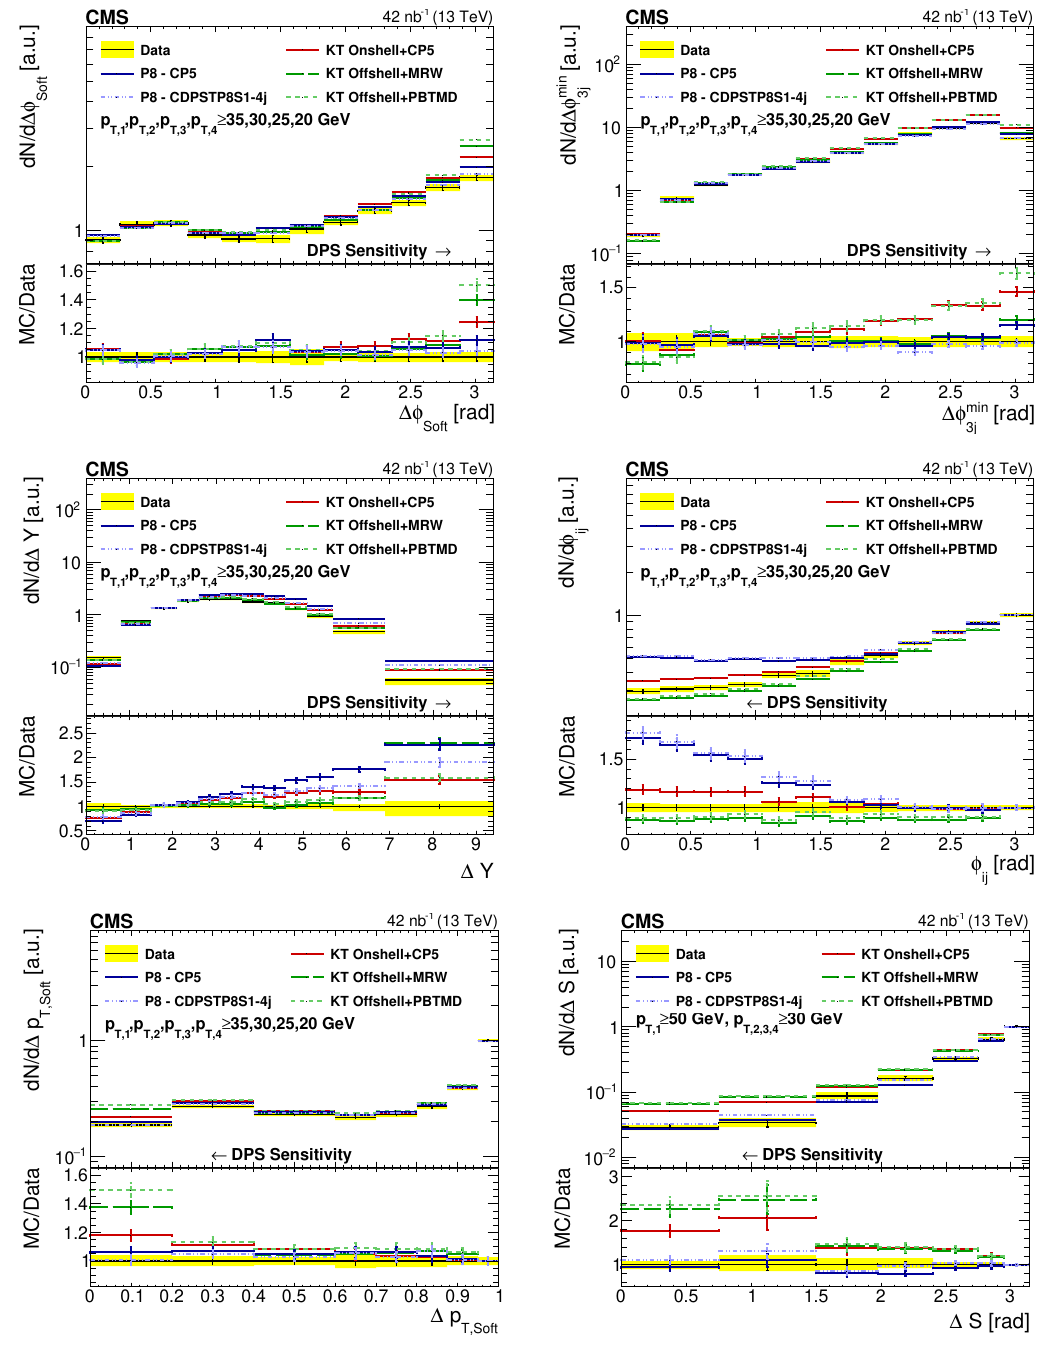
Figure 12 . Comparison of the distributions in DPS-sensitive observables obtained from data to different SPS+DPS KaTie (KT) and pythia 8 (P8) models. All distributions have been determined in Region I, except for the ∆ S distribution which has been measured in Region II. All distributions have been normalized to the region where a reduced DPS contribution is expected. The error bars represent the statistical uncertainty, and the yellow band indicates the total (statistical+systematic) uncertainty on the